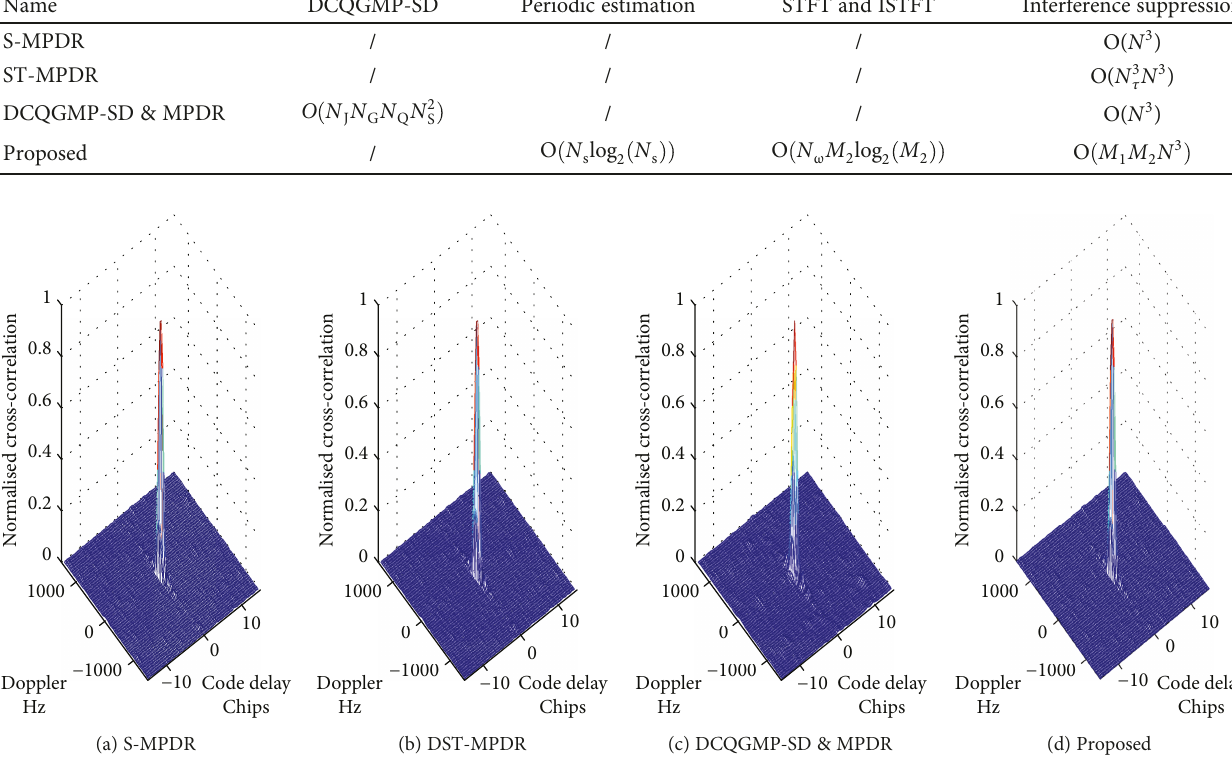
Figure 4: Correlation peaks after interference suppression for scenario I